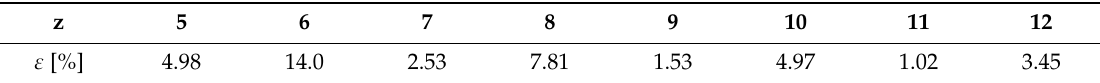
Table 1. Pulsation rate according to the number of